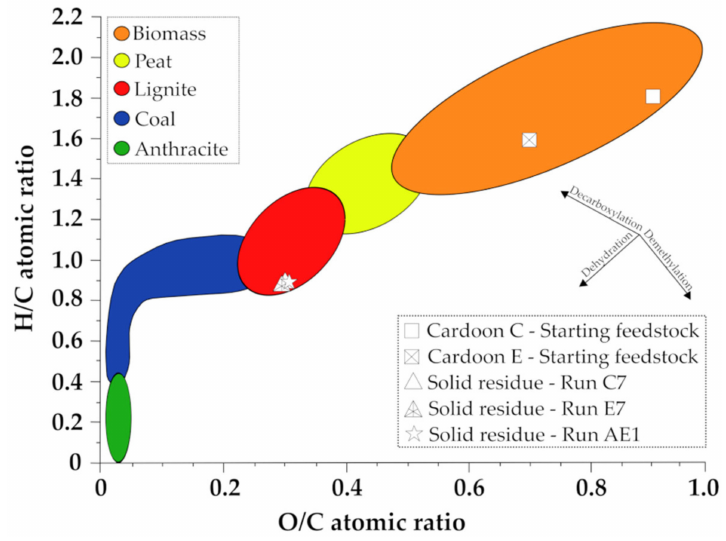
Figure 4. Van Krevelen diagram of starting biomasses, cardoon sample C7 and E7, and solid residues at the end of runs C7 and E7 for alcoholysis and run AE1 for butanolysis.